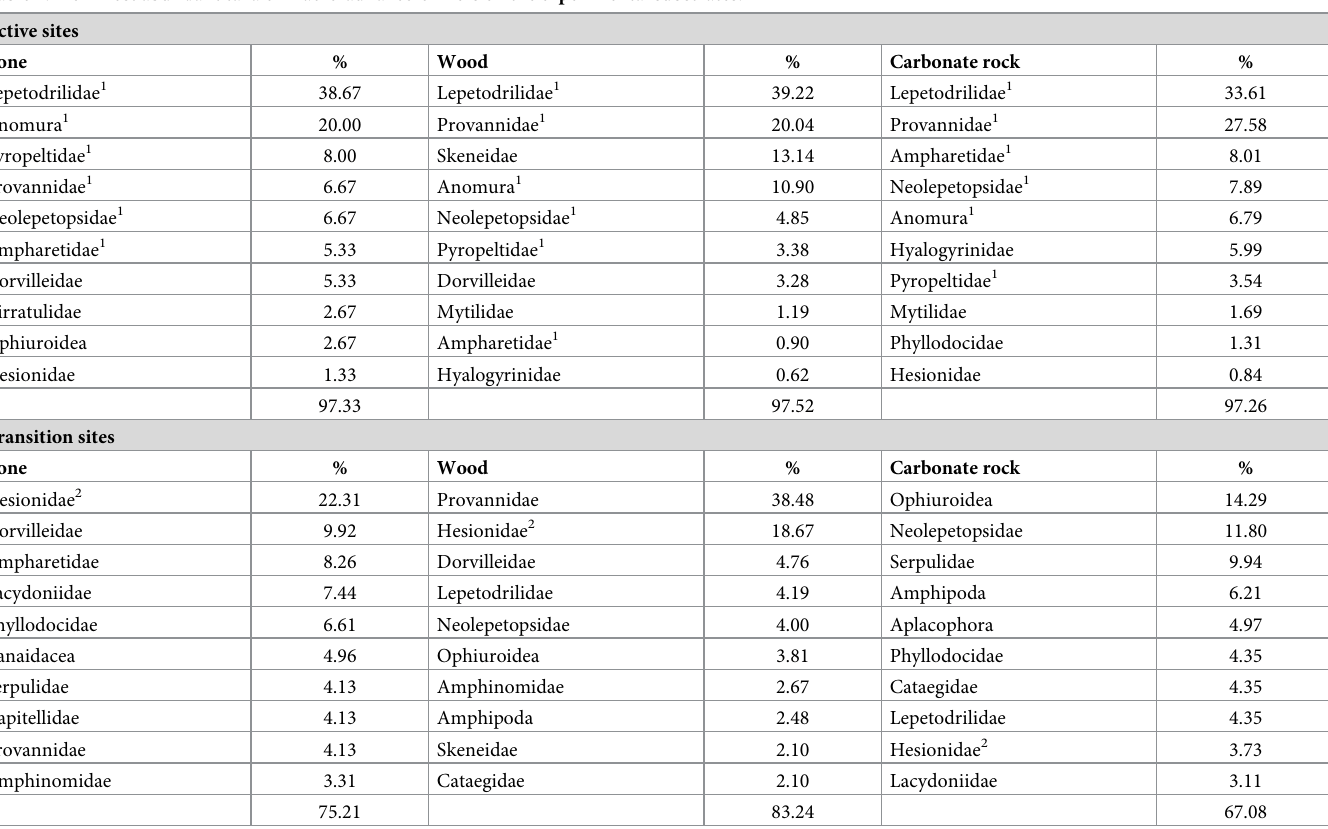
Top ten taxa of macrofaunal colonizers on the experimental substrates. given as percent of the total density for cow bones, woods, and carbonate rocks deployed at active and transition sites at Mound 12 for 7.4 years (2010–2017). 1 Taxa present on all three substrates at active sites. 2 Taxa present on all three substrates at transition